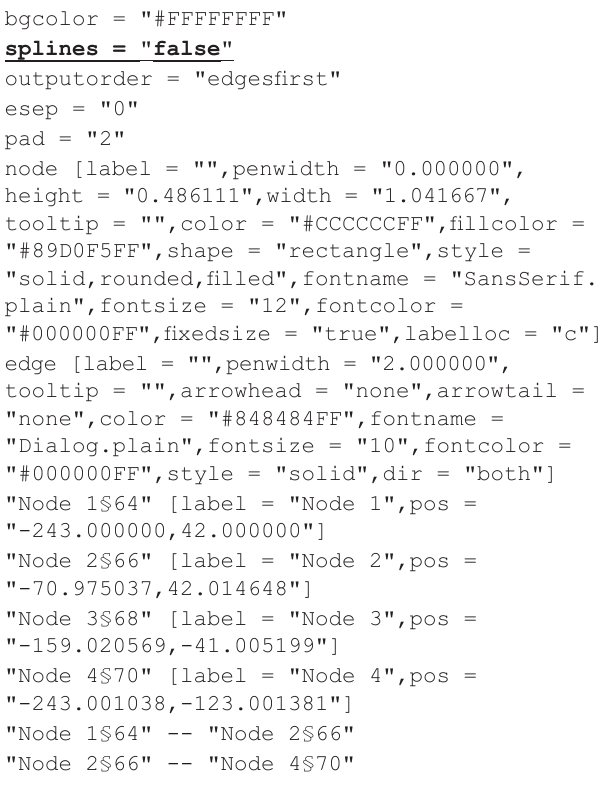
"Node 1§64" -- "Node 3§68"